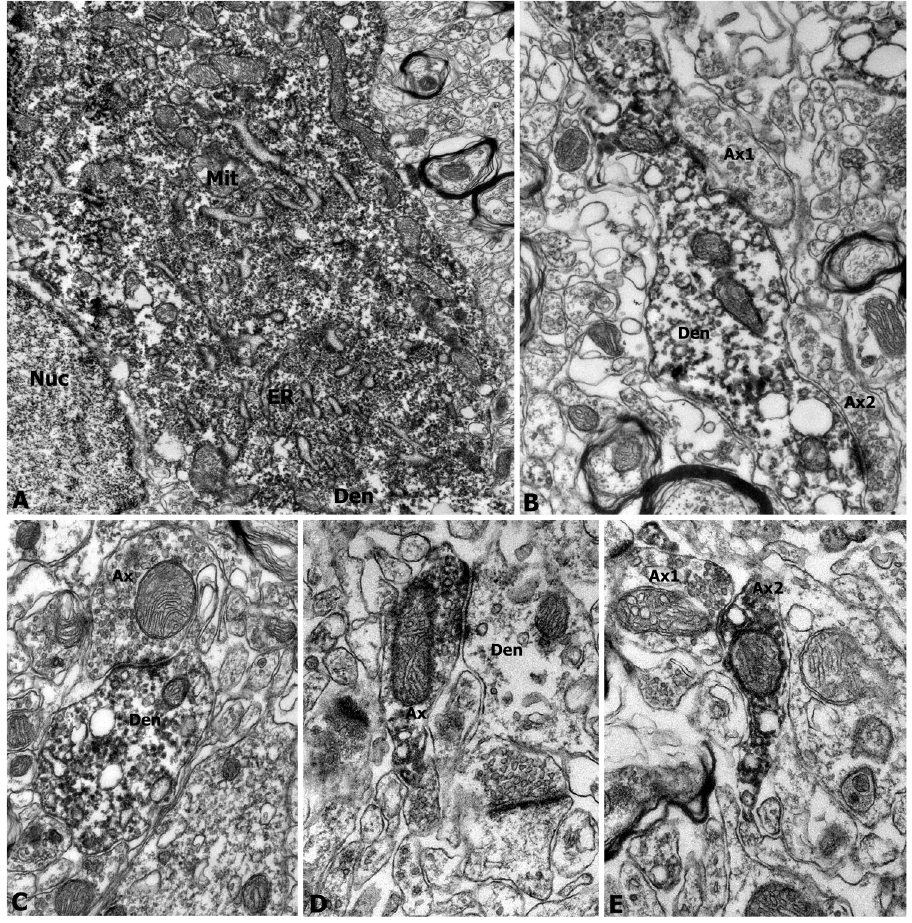
Figure 2. Electron microscopy showing proNGF-positive neuronal somas, dendrite and axonal terminals in nigral and striatal regions of adult rats. The proNGF-positive neuronal somas and dendrites in the substantia nigra ( A – C ) and proNGF-positive axonal terminals in the striatum ( D , E ) are representatively showed. The proNGF-positive products with high density are observed in soma ( A ), dendrites ( B , C ), and axonal varicosities or terminals with synapses or synaptic buttons ( D , E ). Abbreviations: Ax, axon; Den, dendrite; ER, endoplasmic reticulum; Mit, mitochondria; Nuc,